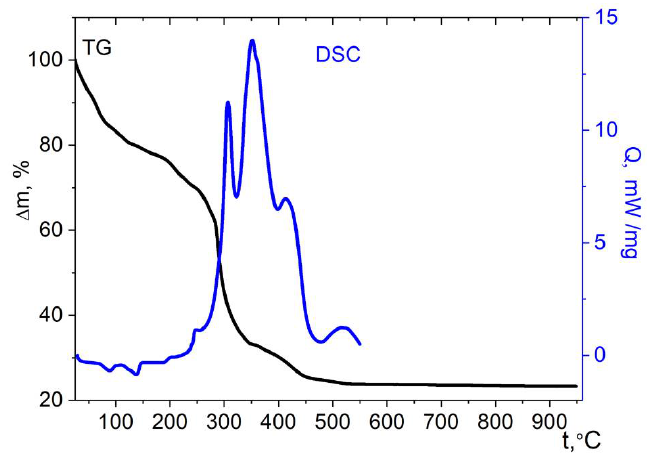
Figure 14 . Thermolysis of complex 6 under air. Figure 14. Thermolysis of complex 6 under